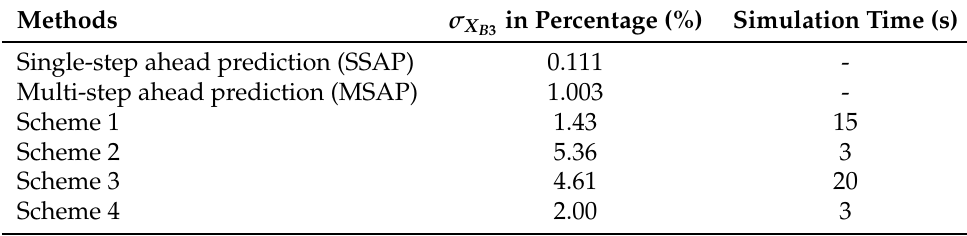
Table 3. σ X values for the trained LSTM model and the different B 3